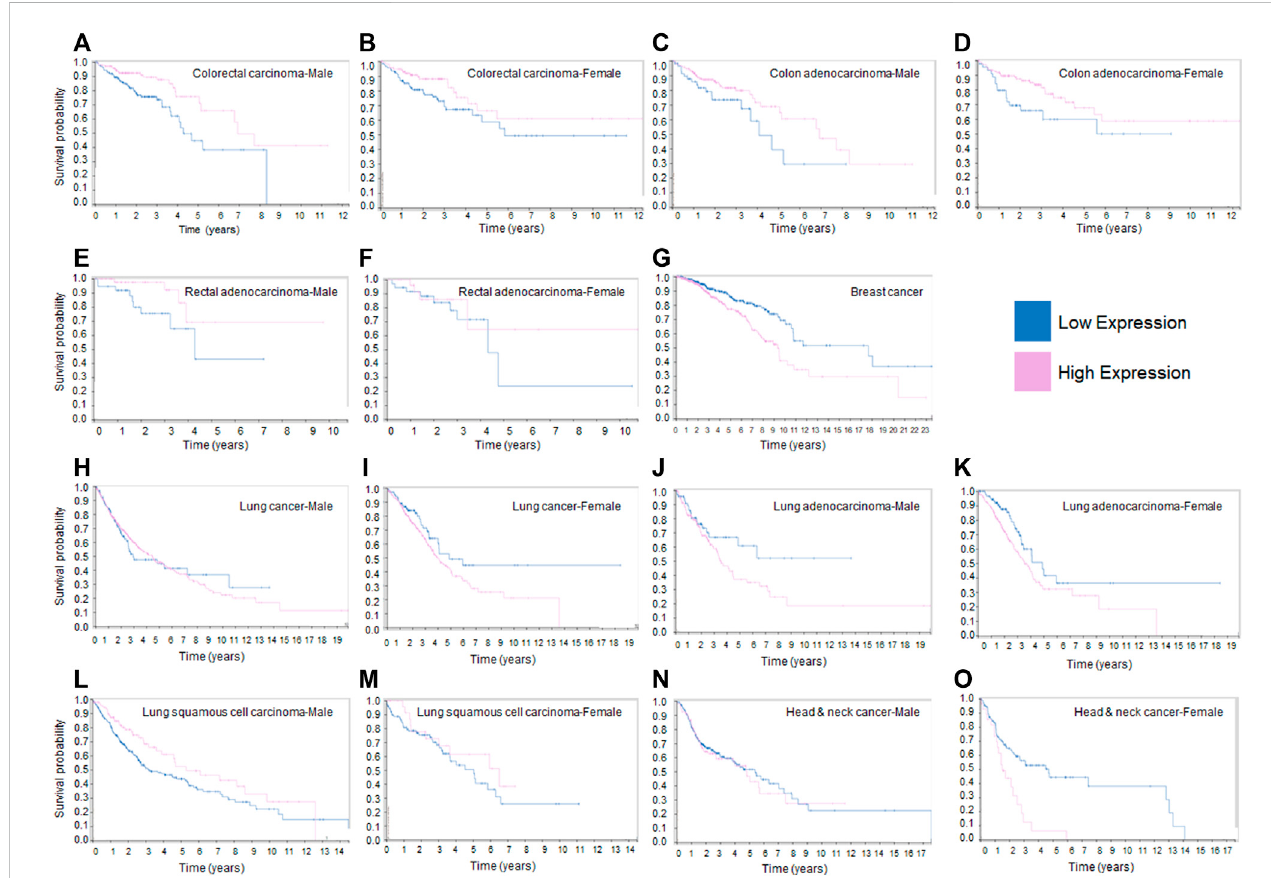
FIGURE 1 Kaplan-MeiersurvivalcurvesofpatientswithdifferenthumancancerssortedaccordingtoexpressionlevelsofHSPA9/mortalin. (A) .Inmalepatientswith colorectal carcinoma, low expression of HSPA9 has a negative effect on survival. (B) . In female patients with colorectal carcinoma, low expression of HSPA9 has a negative effect on survival. (C) . In male patients with colon adenocarcinoma, low expression of HSPA9 has a negative effect on survival. (D) . In femalepatientswithcolonadenocarcinoma,lowexpressionofHSPA9hasanegativeeffectonsurvival. (E) .Inmalepatientswithrectaladenocarcinoma, lowexpressionofHSPA9hasanegativeeffectonsurvival. (F) .Infemalepatientswithrectaladenocarcinoma,lowexpressionofHSPA9hasanegativeeffecton survival. (G) . In female patients with breast cancer, high expression of HSPA9 has a negative effect on survival. (H) . In male patients with lung cancer, HSPA9 expression levels have no effect on survival. (I) . In female patients with lung cancer, high expression of HSPA9 has a non-signi fi cant negative effect on survival. (J) .Inmalepatientswithlungadenocarcinoma,highexpressionofHSPA9hasanon-signi fi cantnegativeeffectonsurvival. (K) .Infemalepatientswith lung adenocarcinoma, high expression of HSPA9 has a non-signi fi cant negative effect on survival. (L) . In male patients with lung squamous cell carcinoma, HSPA9 expression levels have no effect on survival. (M) . In female patients with lung squamous cell carcinoma, HSPA9 expression levels have no effect on survival. (N) .Inmalepatientswithheadandneckcancer,HSPA9expressionlevelshavenoeffectonsurvival. (O) .Infemalepatientswithheadandneckcancer, high expression of HSPA9 has a non-signi fi cant negative effect on survival. The prognostic value of mortalin RNA expression in different cancers illustrated in this fi gure were downloaded from the Human Protein Atlas: